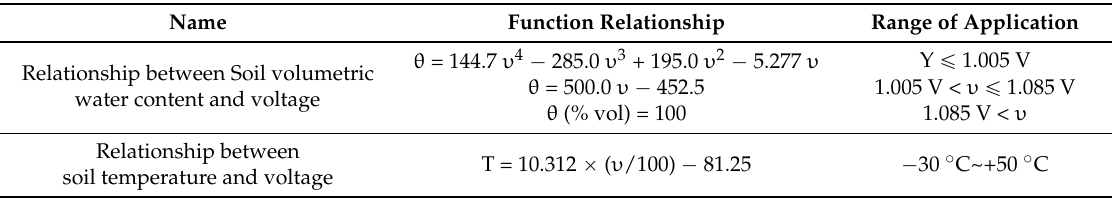
Table 1. Temperature and moisture content results of